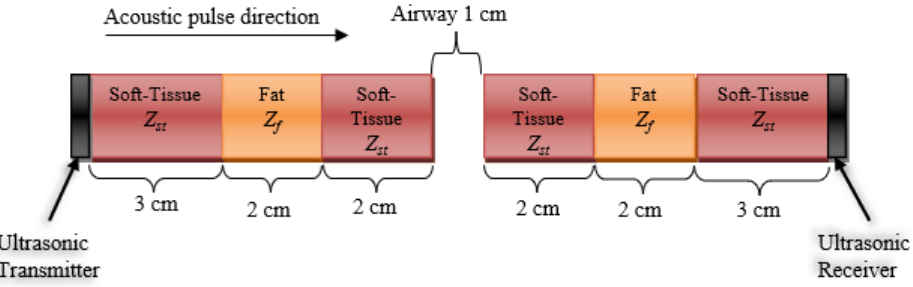
Figure 4. A stratified model of a normal-sized neck and its tissue composition with an open airway in the path of an acoustic pulse traveling left to right (from a transducer on the neck surface, through stratified layers of soft tissue and fat, with an acoustic impedance of Z st and Z f , respectively. The acoustic impedance of air is Z a , while it is Z t for the transducer. The signal loses strength due to reflection and absorption